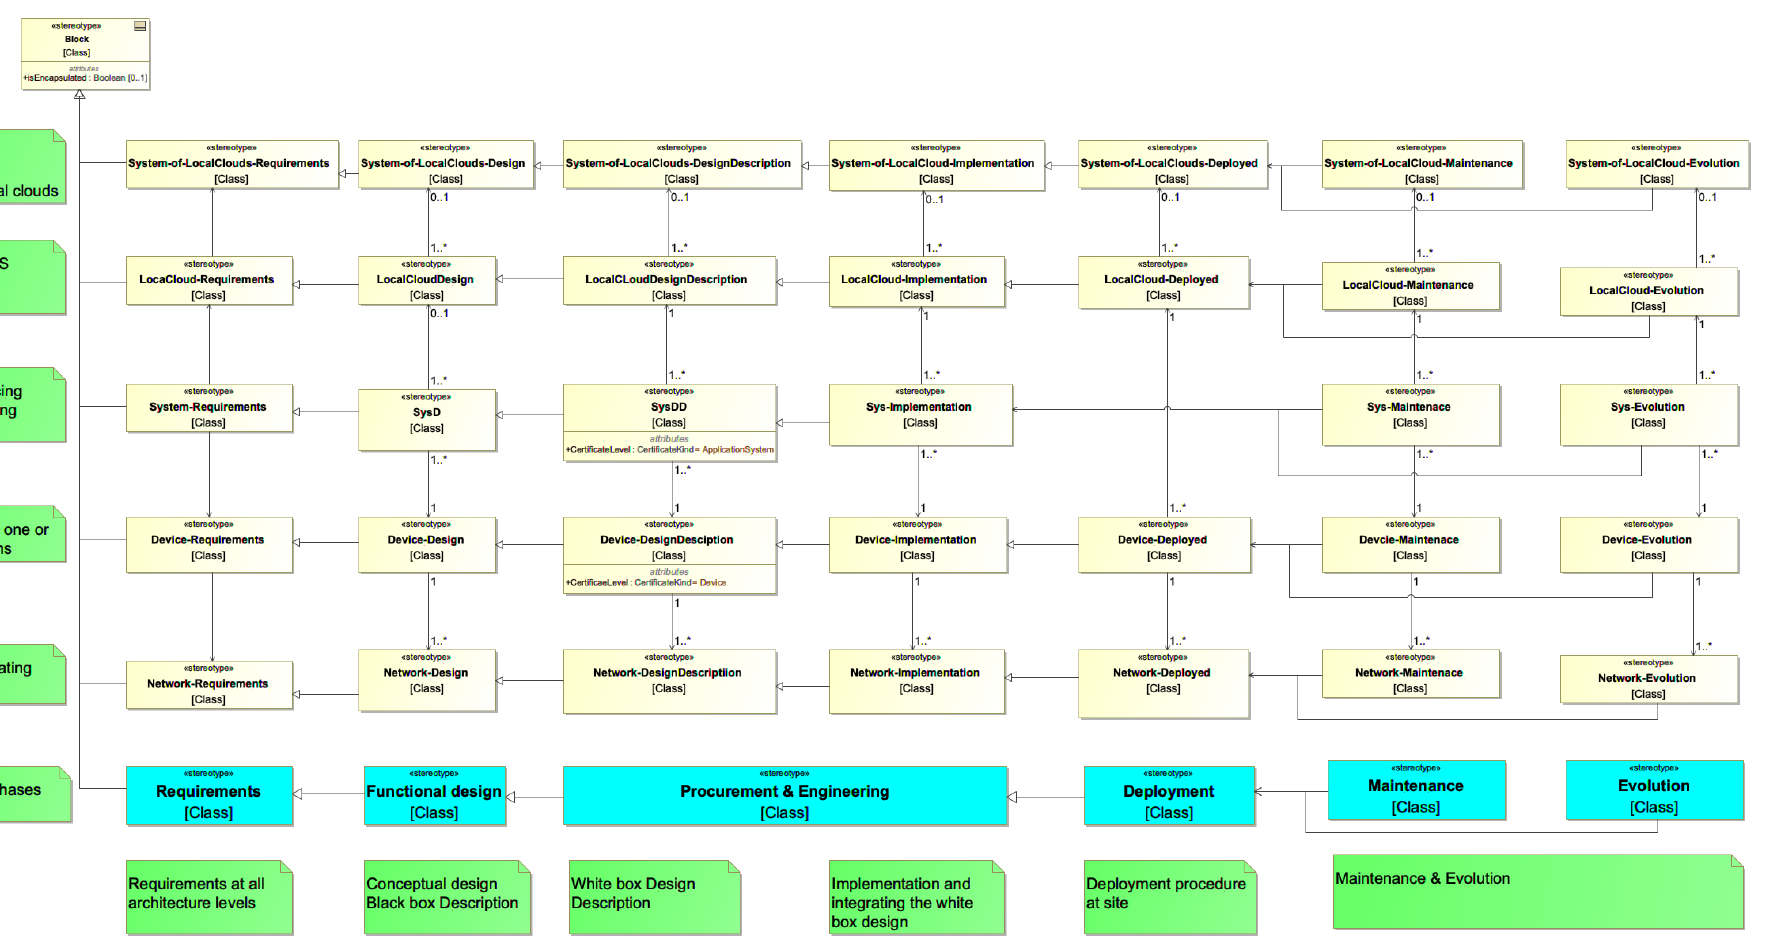
Figure 4. The two engineering approach dimensions. From bottom row up—the architecture dimension starting at the network and device levels up to large-scale SoS level. Thus, enabling the capturing of the very large scale expected in smart cities. The engineering dimension starts with requirements, high-level functional objective, and design, all the way to deployment, maintenance, and evolution. Architectural block relationships and associated constraints are modeled with SysML directed